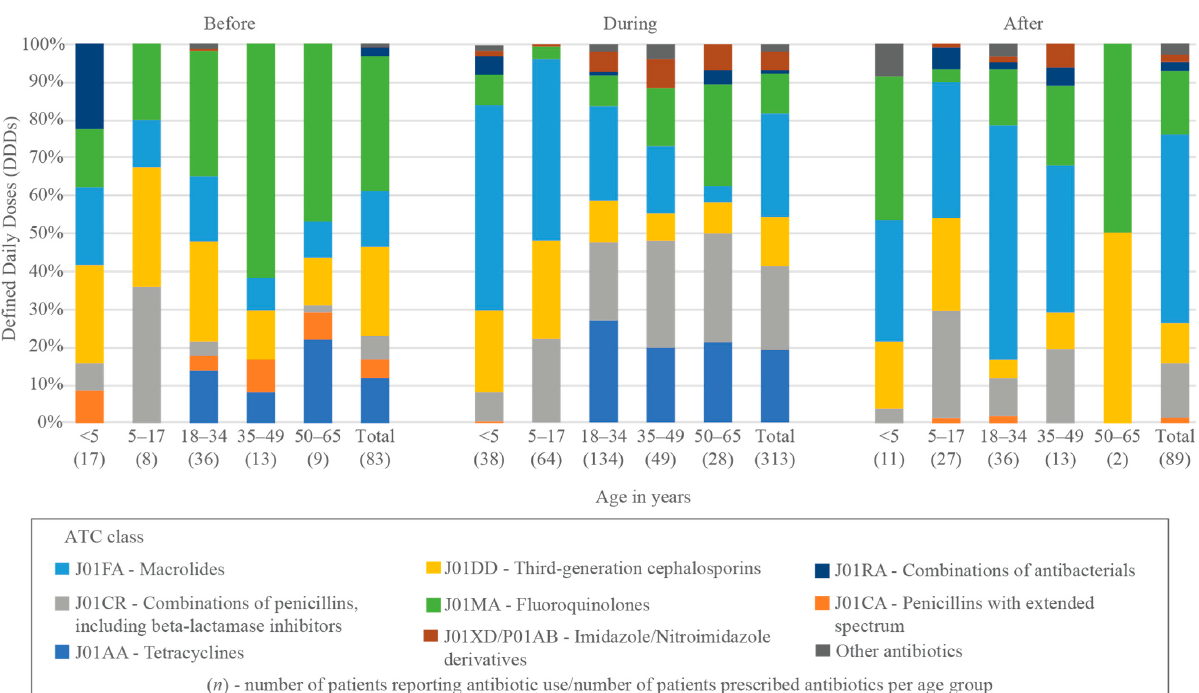
Figure 1. Distribution of antibiotic use before, during, and after outpatient visit across age groups, according to the WHO AWaRe classification by percentage of encounters.